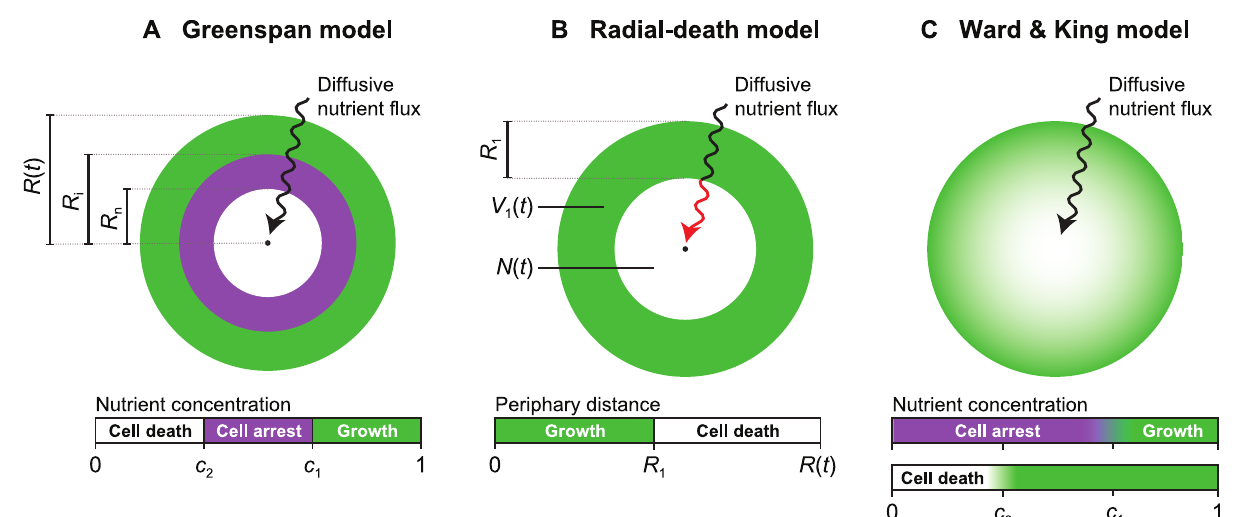
Fig 3. Schematic of the spatial spheroid models considered. (A) The Greenspan model describes nutrient-limited growth, where cell proliferation is dependent upon the relative availability of a diffusive nutrient. Cells proliferate in regions of the spheroid where the nutrient concentration is sufficiently high; enter cell-cycle arrest, but do not die, in regions where the nutrient concentration is too low for growth, but above the threshold for life; and die in regions where the nutrient concentration is sufficiently low. (B) The radial-death model describes an implicitly modelled diffusive nutrient, which is assumed to drop below the threshold required for cell proliferation at a constant distance from the spheroid periphery. (C) Ward and King’s model describes both cell proliferation and death as dependent on a diffusive nutrient that is explicitly modelled as a function of space.